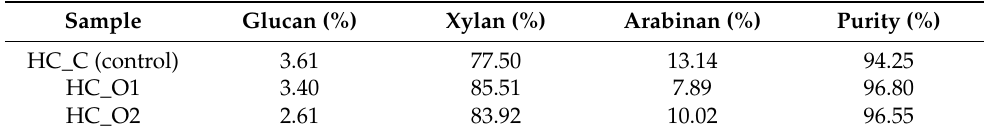
Table 6. Main chemical components of hemicelluloses preparations isolated from wheat straw.